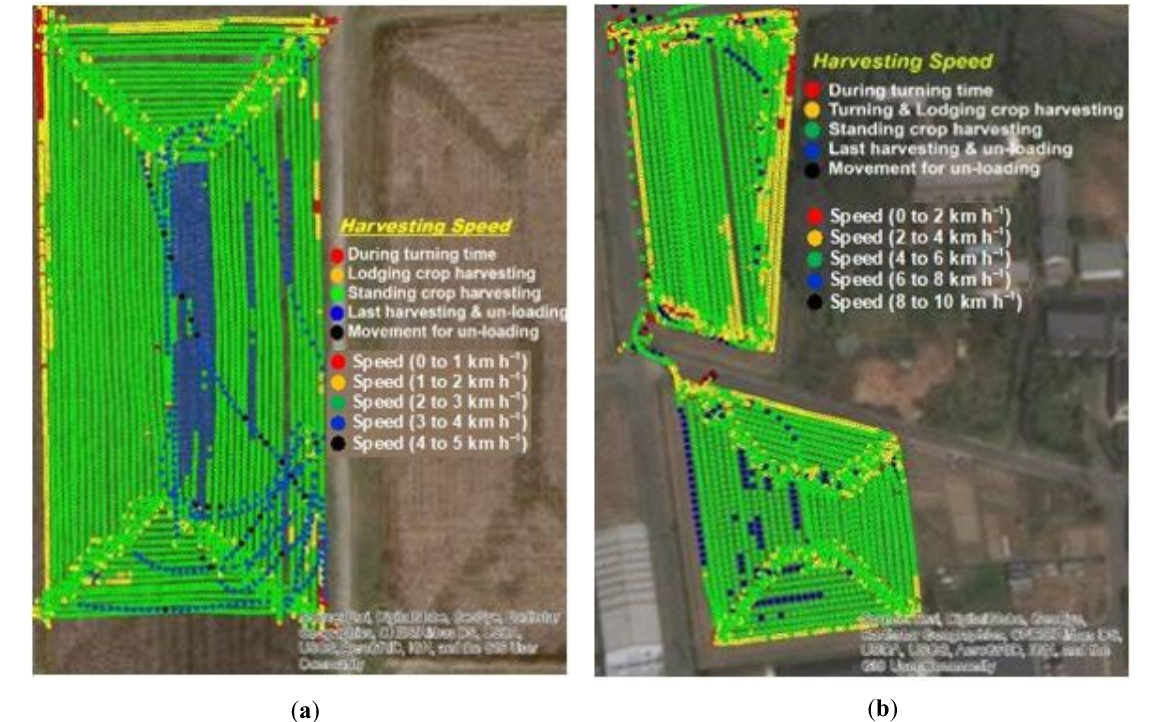
Figure 5. Harvester speed variations: ( a ) Plot 1 at Gifu University; ( b ) Plots 2 and 3 at Kaizu. Speed variations are presented by 5 different colors: red, yellow, green, blue, and black. The values of different speed ranges are classified from 0 to 1, 1 to 2, 2 to 3, 3 to 4, and 4 to 5 km h − 1 for the medium combine and from 0 to 2, 2 to 4, 4 to 6, 6 to 8, and 8 to 10 km h − 1 for the large combine and are shown in red, yellow, green, blue, and black, respectively.